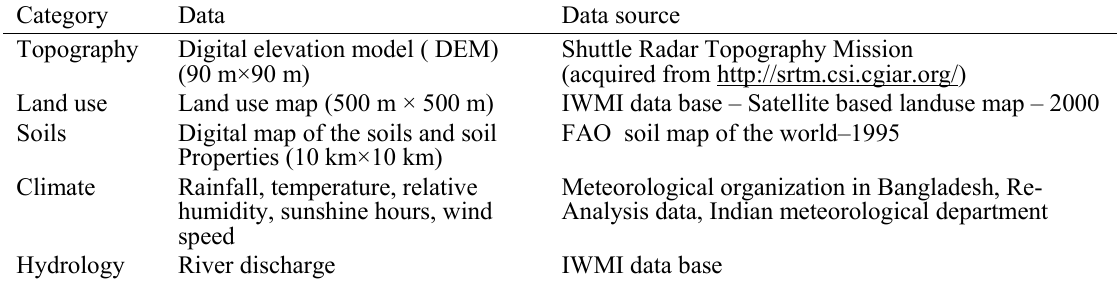
Table 1 An overview of main data sets used in this